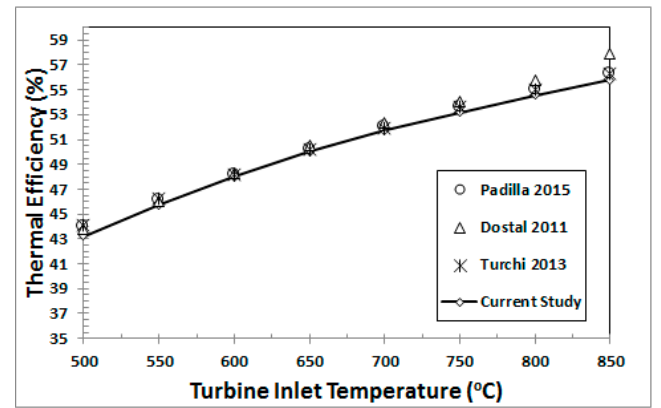
Figure 5. Validation of simulation results for the RBC-PC with [11,16,17].